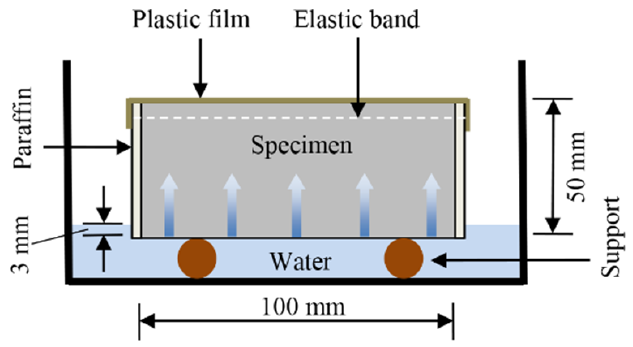
Figure 3. Schematic of the sorptivity test.